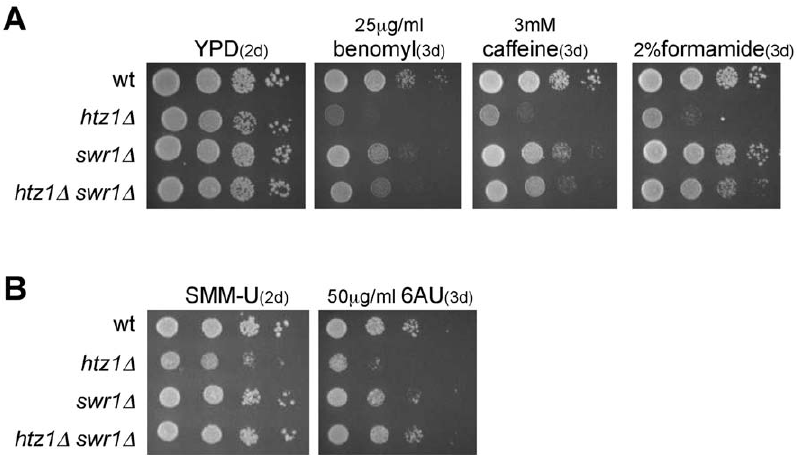
Figure 4. Swr1 causes sensitivity to stress conditions in the absence of Htz1. Stress sensitivity of htz1 D , swr1 D and htz1 D swr1 D (W303-1a) as determined by plating ten-fold serial dilutions from the same number of mid-log phase cells onto YPD plates with or without benomyl, caffeine or formamide, or SMM without uracil (SMM-U) plates with or without 6-AU. Cells were incubated at 30 u C for 2–3 days as indicated.